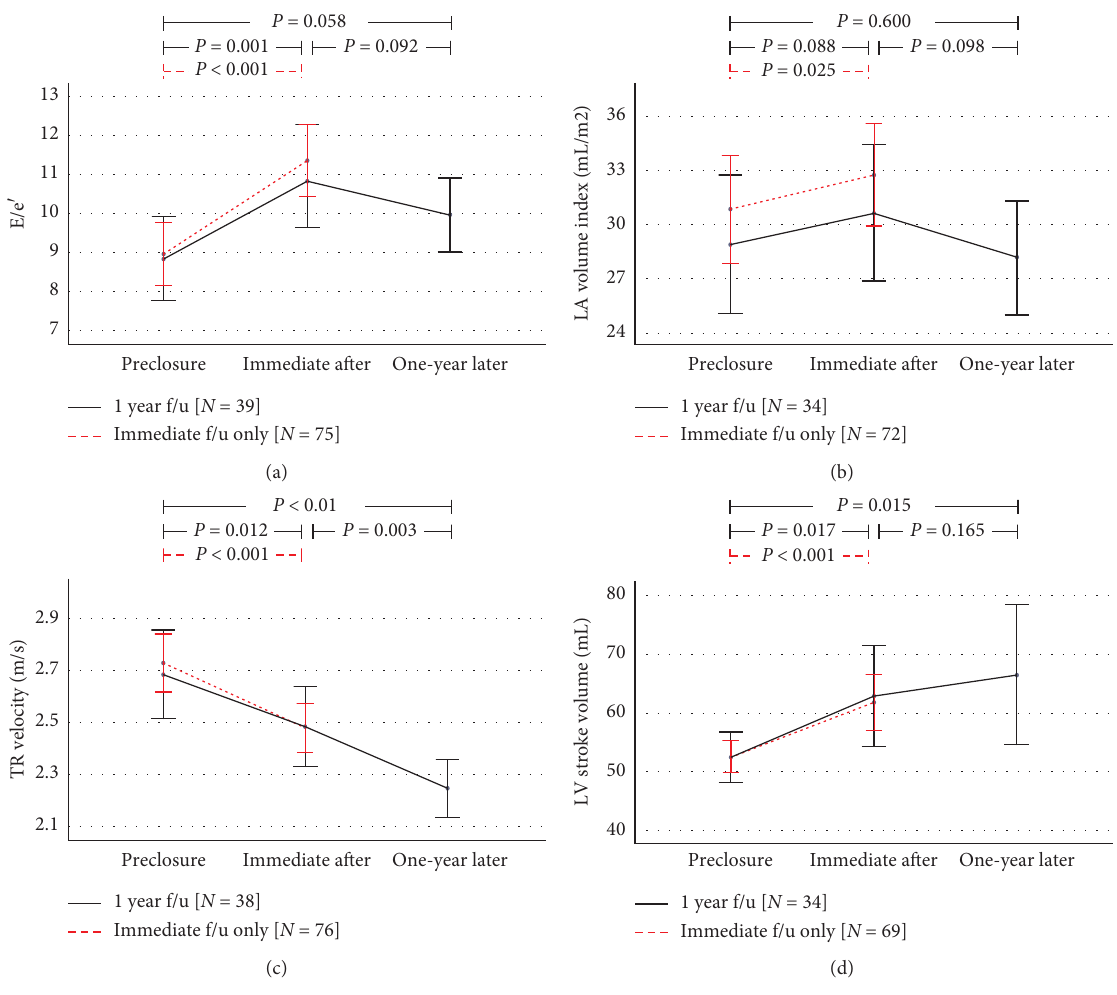
Figure 2: Serial changes in E/e’ (a), left atrial (LA) volume index (b), tricuspid regurgitant (TR) velocity (c), and left ventricular (LV) stroke volume (d) from preclosure to one-year follow-up ( n � 39). Blue dotted line represents comparisons between preclosure state and im- mediately after (one-day after closure) follow-up only ( n � 78). Bars represent 95% confidence intervals. Table 3: Correlations of immediate E/e’ changes after device closure of an